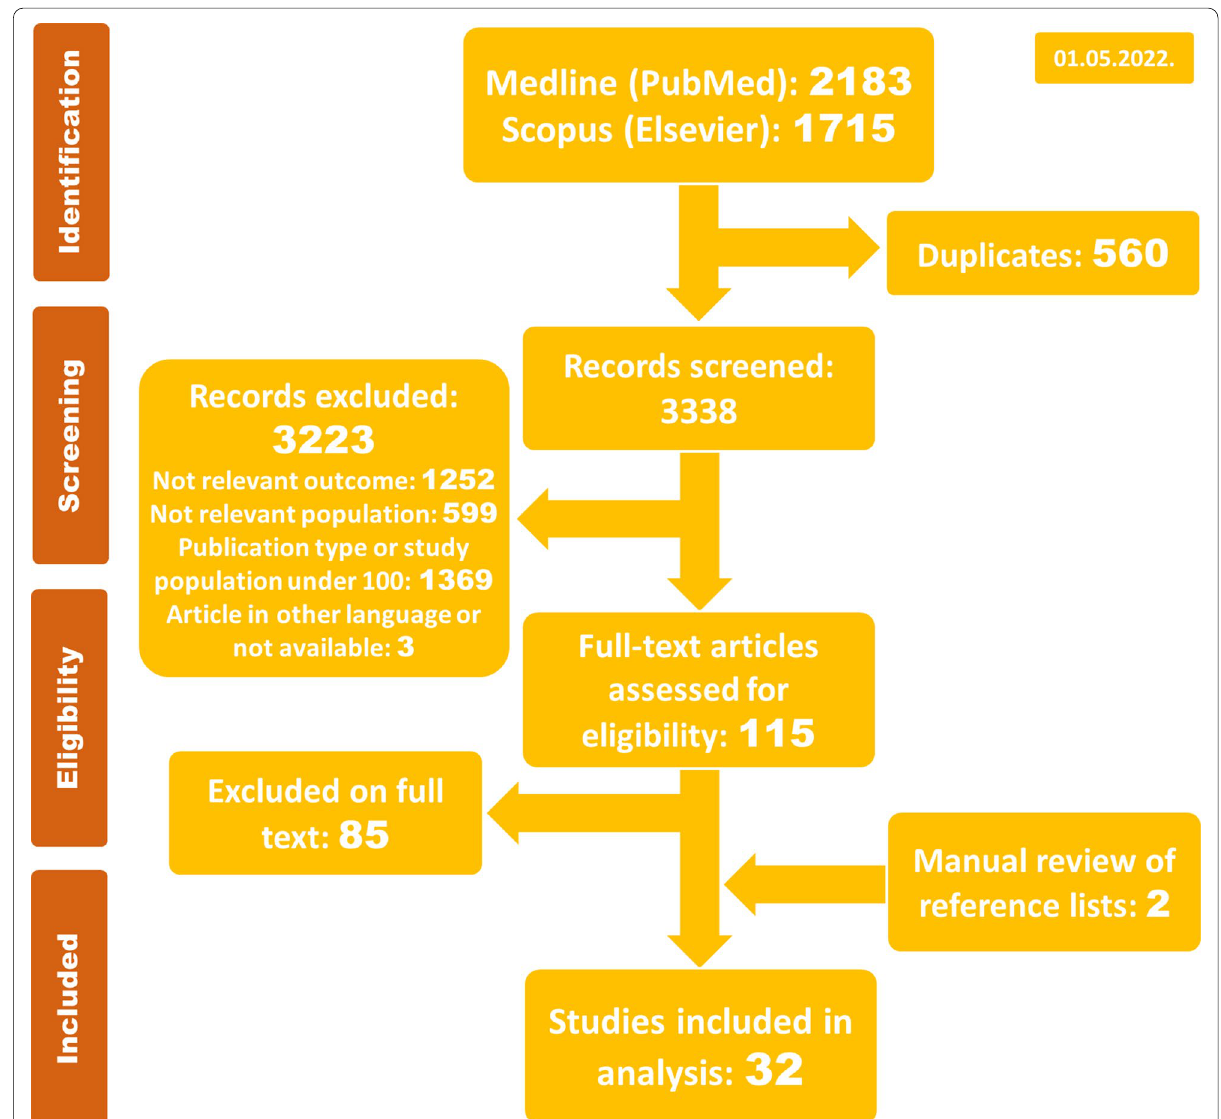
Fig. 1 Preferred reporting items for systematic reviews and meta-analyses (PRISMA) flow chart of the search